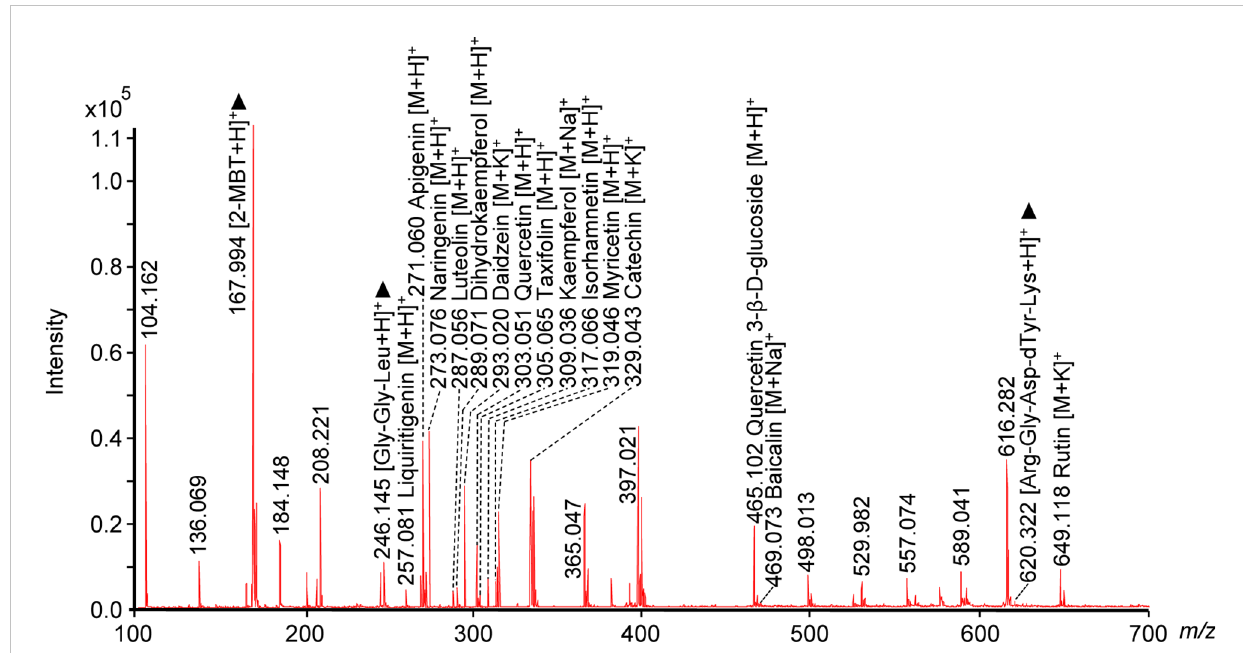
FIGURE 3 Mass spectrum of fl avonoids detected in situ in a litchi seed tissue section using MALDI-TOF-MS and 2-MBT as the matrix in the positive ion mode. Two peptide standard ions, Gly-Gly-Leu (tripeptide, [M+H] + , m/z 246.145) and Arg-Gly-Asp-dTyr-Lys (pentapeptide, [M+H] + , m/z 620.322), and one matrix ion, 2-MBT ([M+H] + , m/z 167.994), were used as the reference peaks and are labeled with black triangle “ ▲ ” . Three biological repetitions and three technical repetitions were performed (n = 3 × 3). MALDI, matrix-assisted laser desorption/ionization; TOF, time-of- fi ght; MS,